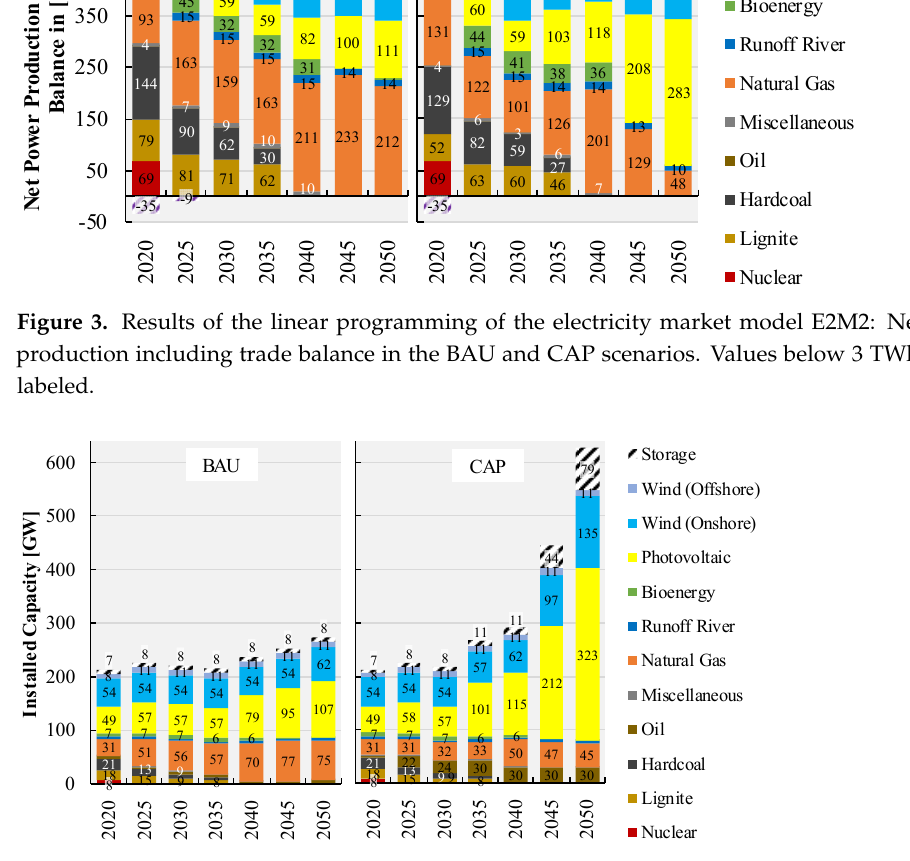
Figure 4. Results of the linear programming of the electricity market model E2M2: Installed capacity of the two scenarios BAU and CAP to the year 2050. Values below 3 TWh are not labeled.